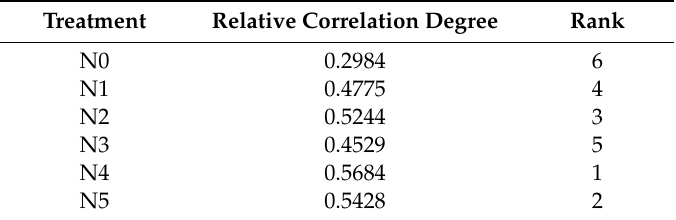
Table 2. Comprehensive quality evaluation results of Astragalus mongolica under di ff erent